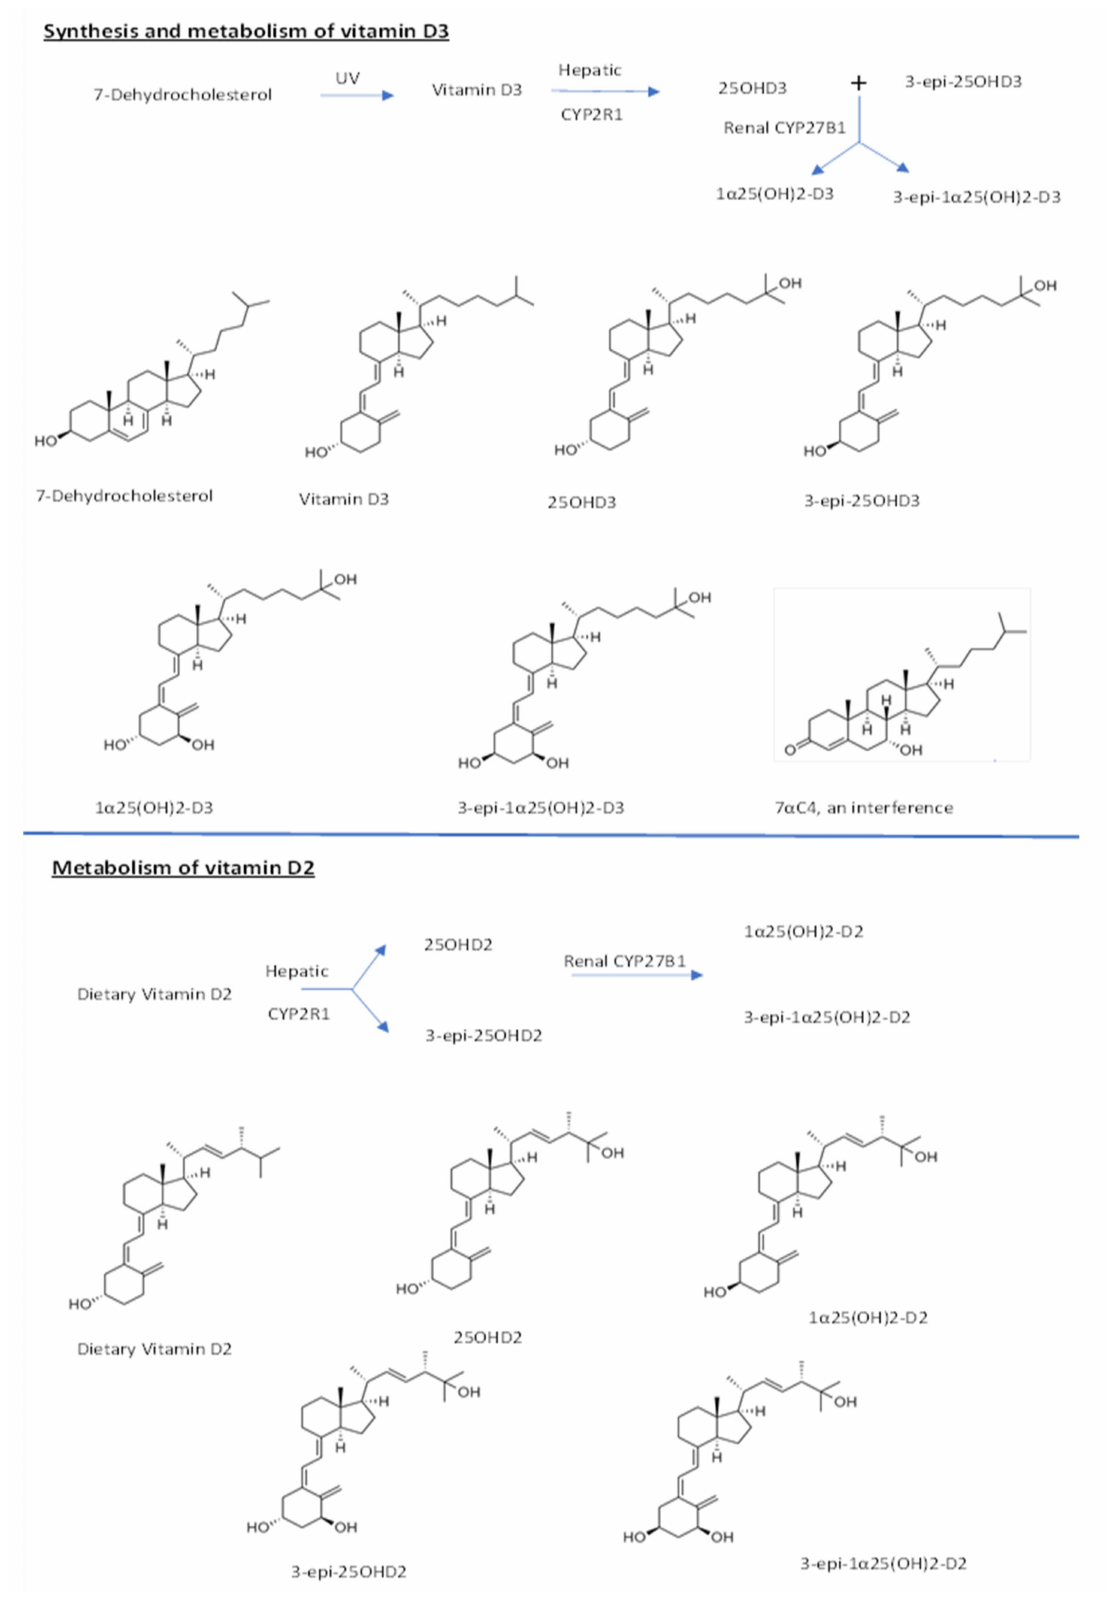
Figure 1. Metabolic pathways for vitamins D2, D3, and chemical structures of